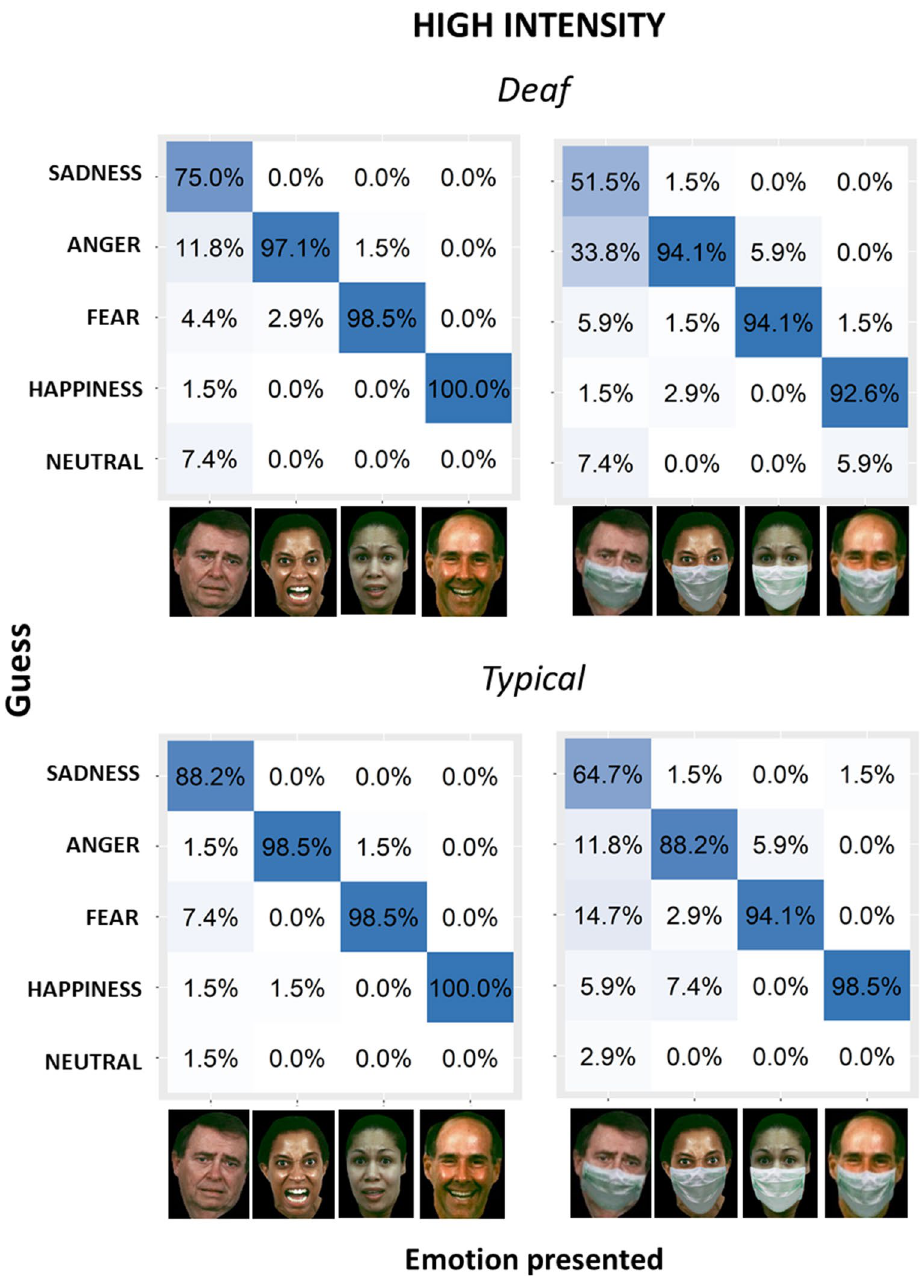
stimuli public database 29,30